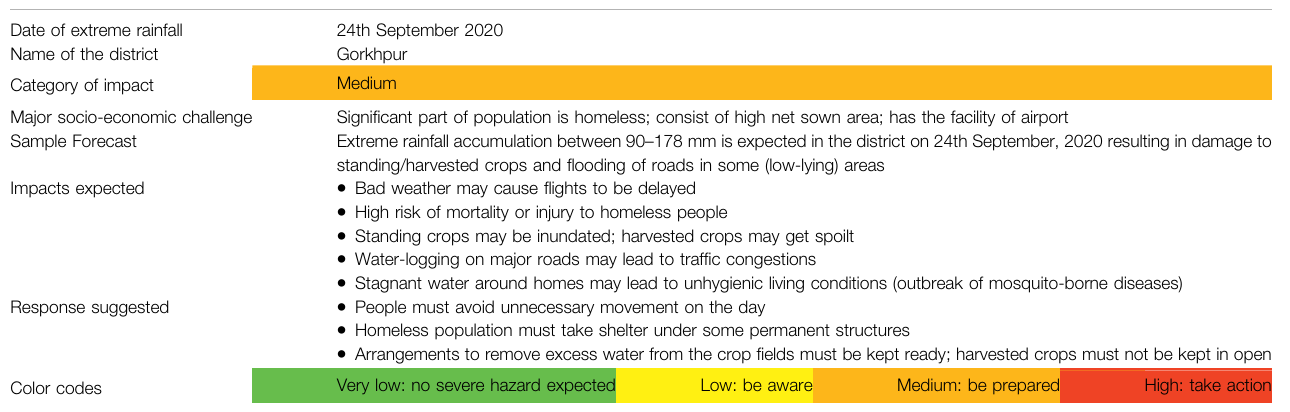
TABLE 4 | A sample IBF generated for the district